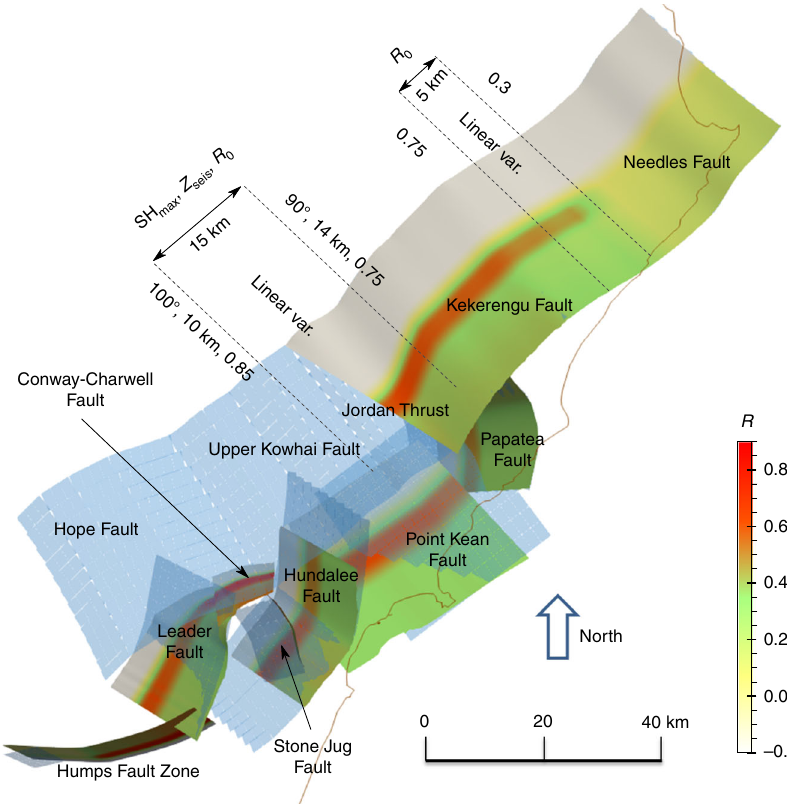
Fig. 2 Adaptations made to the geodetically inferred fault geometry to develop a realistic dynamic rupture model. Changes made to the fault geometry are highlighted by plotting the here used geometry over the fault geometry of Xu et al. 7 shown in transparent blue. The distribution of initial fault stress ratio R (Eq. 10) along the fault network is also shown. The spatial distribution of parameters de fi ning the stress (SH max , R , and z seis de fi ned in “ Initial stresses ” in Methods section) are indicated. The magnitude of the initial stress loading is decreased in the Needle fault region to prevent large slip on this optimally oriented segment (such a decrease is modeled by decreasing R 0 by 60% and suppressing the deep stress concentrations in that